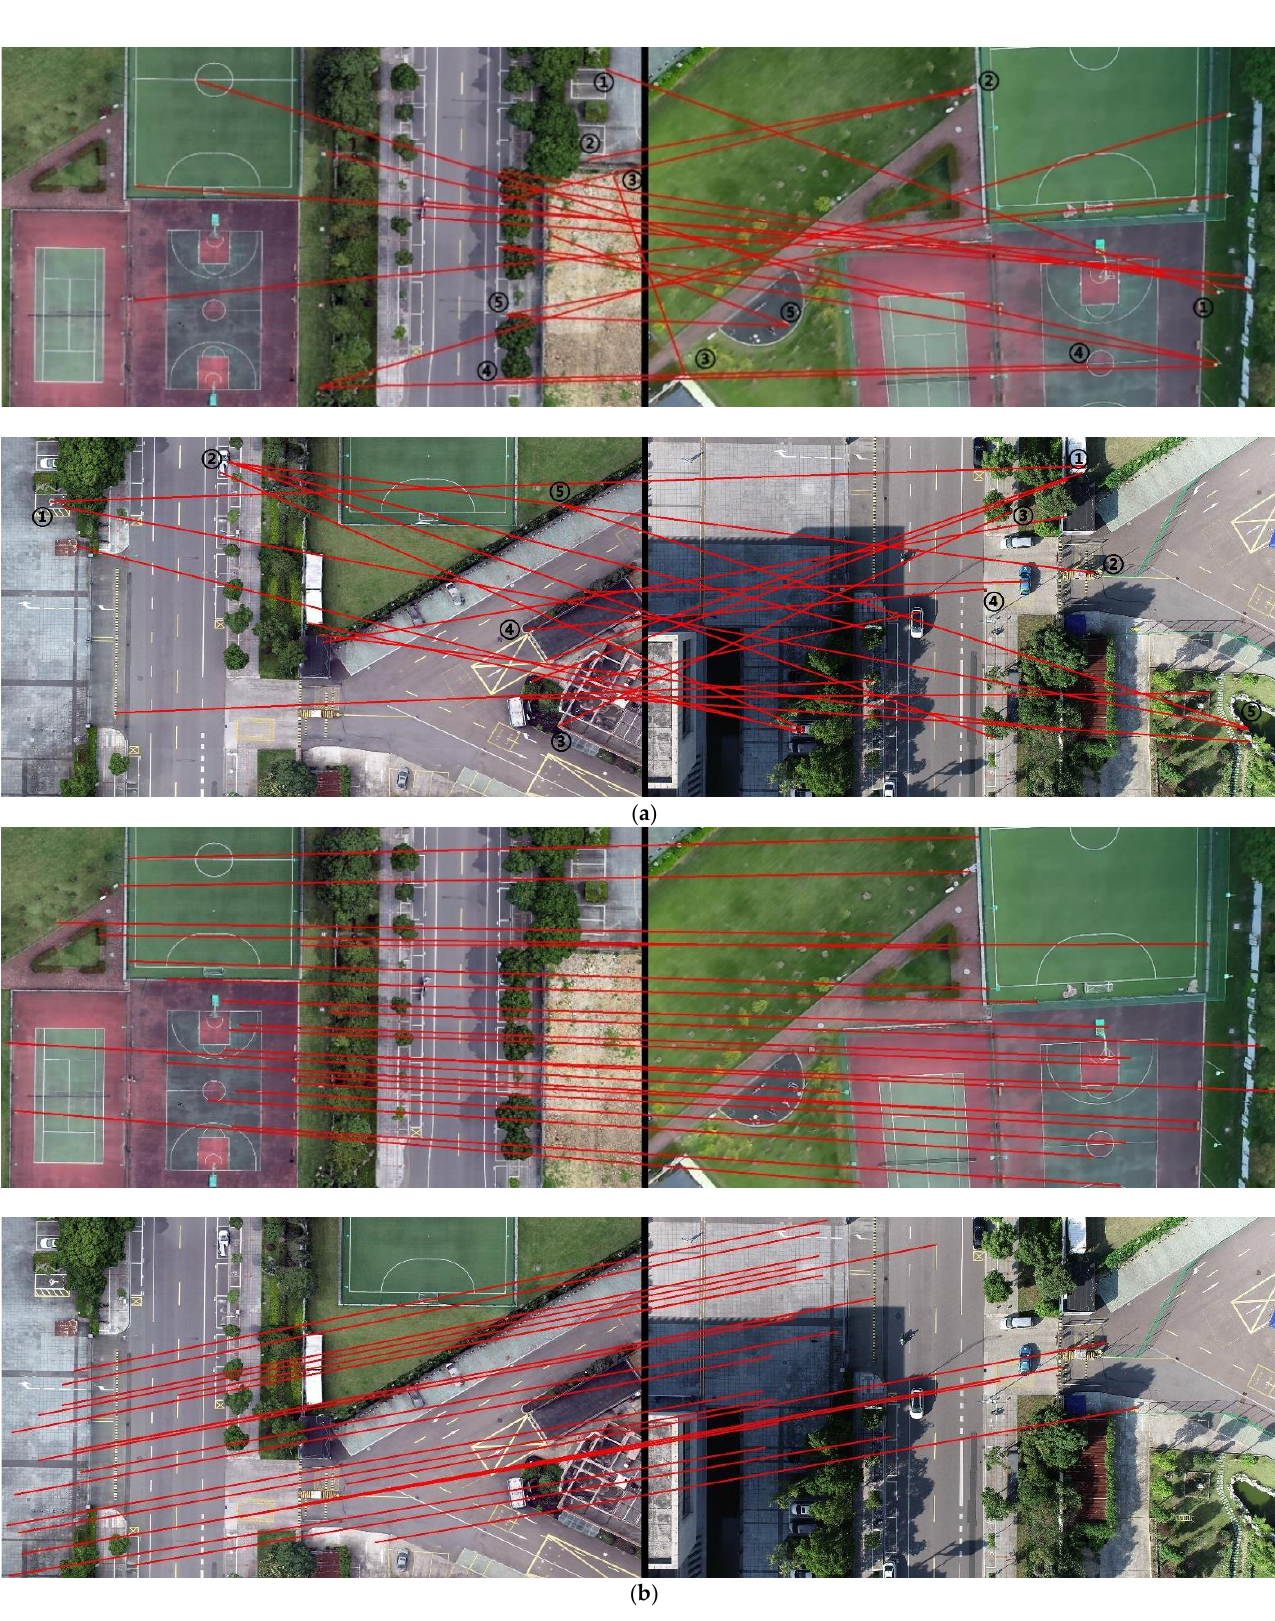
Figure 10. Comparison of feature matching between the Orb and SuperGlue algorithms: ( a ) Orb feature matching (left: map, right: camera, the numbers in the figure represent incorrect matches); ( b ) SuperGlue feature matching (left: map, right: camera).